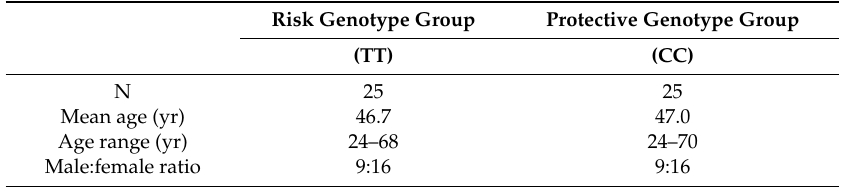
Table 1. Demographic characteristics for the 50 healthy subjects included in the study. A risk genotype (TT) is defined as a homozygous carrier of the risk allele (T) for both MS-associated IL2RA SNPs rs2104286 and rs11256593. A protective genotype (CC) is defined as a homozygous carrier of the protective allele (C) for both MS-associated IL2RA SNPs rs2104286 and